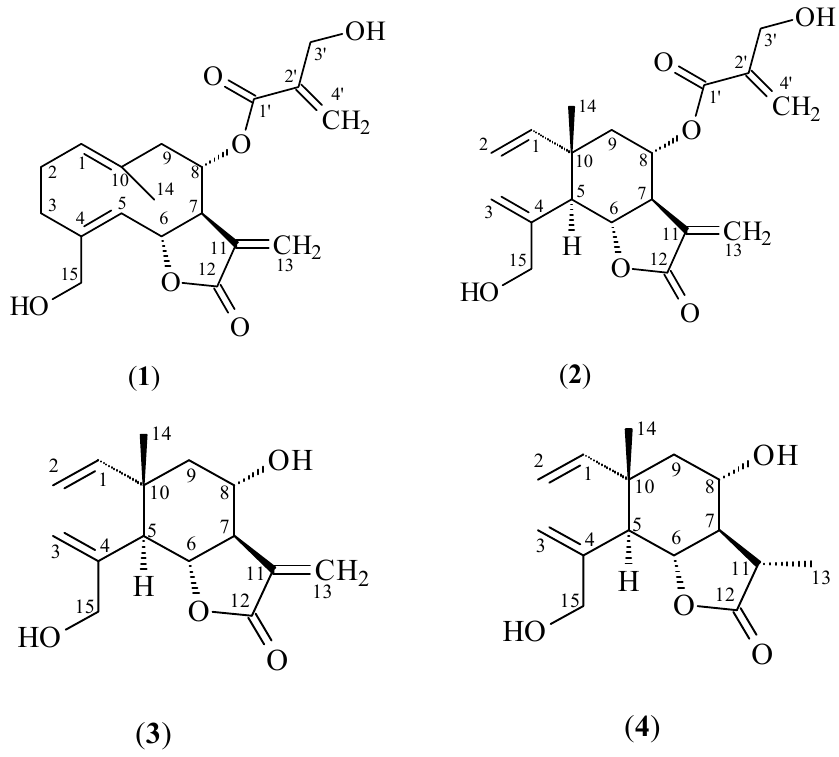
Figure 1. Compounds isolated from the leaves of Arctium lappa : onopordopicrin ( 1 ), dehydromelitensin-8-(4'-hydroxymethacrylate) ( 2 ), dehydromelitensin ( 3 ), melitensin ( 4 ), dehydrovomifoliol ( 5 ), and loliolide ( 6